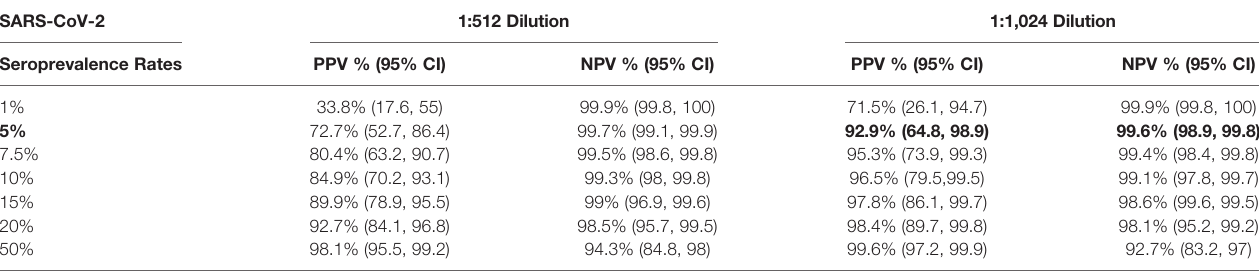
TABLE 1 | Positive predictive value (PPV) and negative predictive value (NPV) of SARS-CoV-2 IgG at different SARS-CoV-2 seroprevalence rates. SARS-CoV-2 1:512 Dilution 1:1,024 Dilution